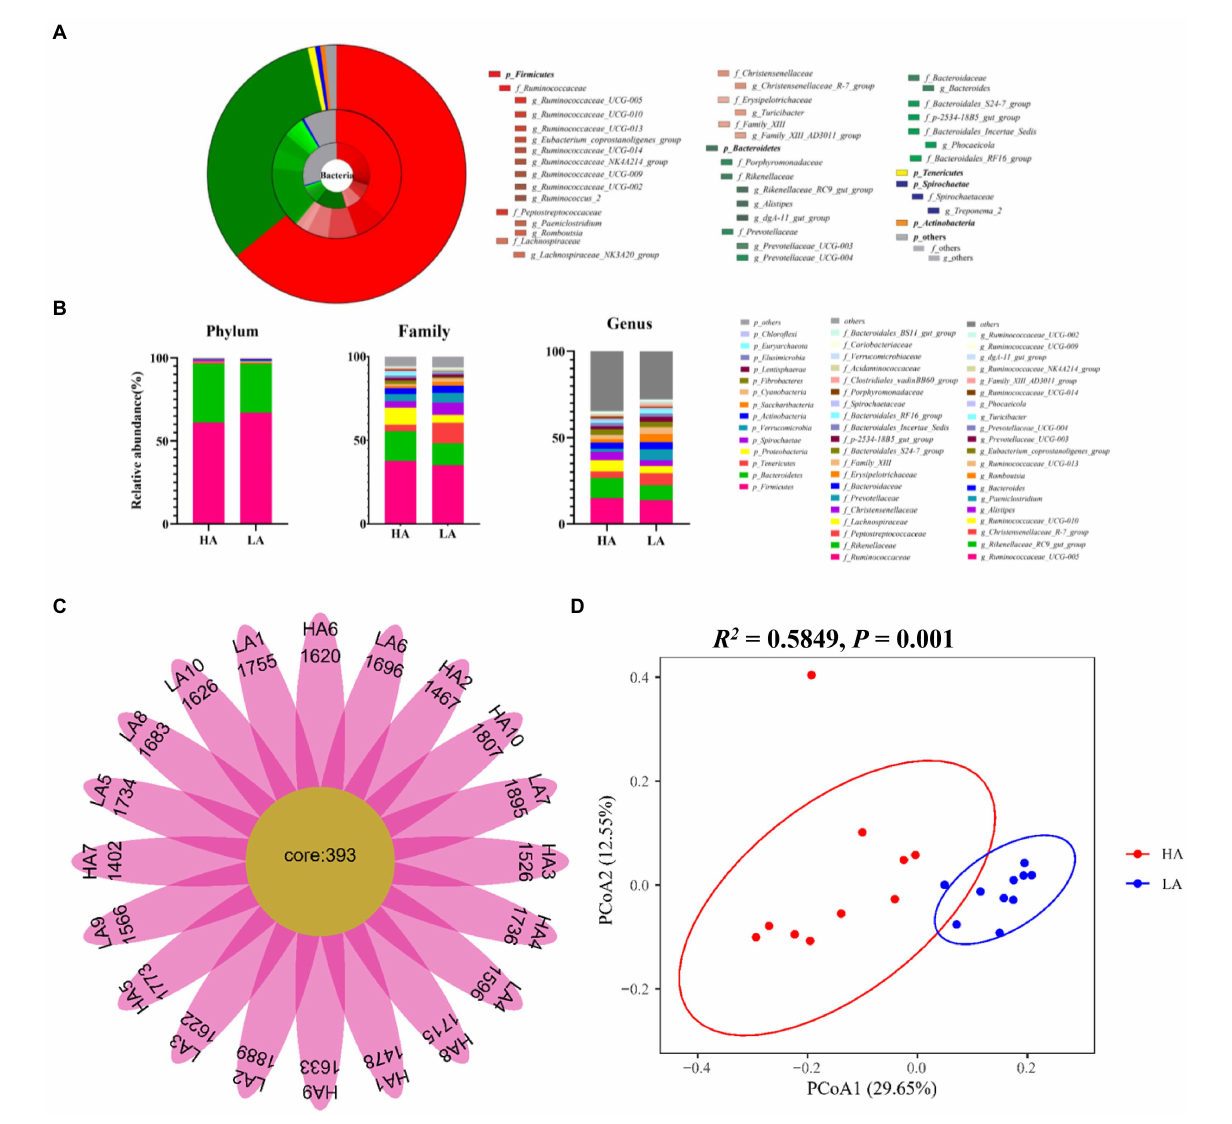
FIGURE 1 The gut bacterial composition of Sanhe heifers. (A) Relative distribution of the most dominant bacterial phyla, family, and genera (relative abundance >0.5% of all the 20 samples) in the low-altitude (LA) and high-altitude (HA) group samples. The inner ring in the pie chart represents the genus level, the middle ring represents the family level, and the outer ring represents the phylum level. Different color shades represent different bacteria. The numbers in brackets denote the average relative abundance of the bacteria across 20 samples. (B) Stacked bar graphs of the average relative abundances of phyla, family, and genus (top 20 of relative abundances) for Sanhe heifers in the LA and HA groups. (C) Flower diagram plot of Sanhe heifer samples. The core community in all Sanhe heifers was defined as operational taxonomic units present in all Sanhe heifers at all sampling times. (D) Principal coordinate analysis (PCoA) plots of bacterial communities in Sanhe heifer